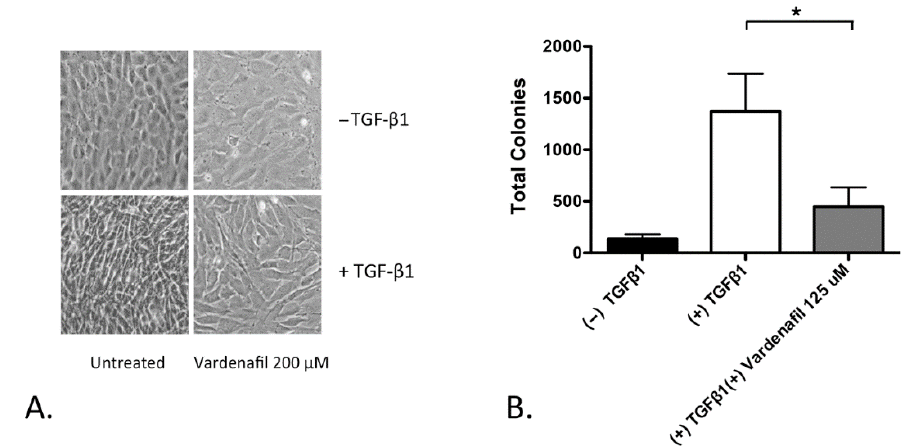
Figure 2. Vardenafil inhibited morphological transformation and anchorage-independent growth (AIG) of fibroblasts. ( A ) Photographs of representative fields are shown with indicated pretreatments in AKR-2B fibroblasts, demonstrating that TGF- β1 induced morphological changes, which were suppressed in the presence of vardenafil. ( B ) In addition, AKR-2B soft agar anchorage independent growth experiments demonstrate that vardenafil significantly reduced the numbers of anchorage-independent colonies formed during culture. The data represent the mean ± SEM. * p < 0.05 on the comparison